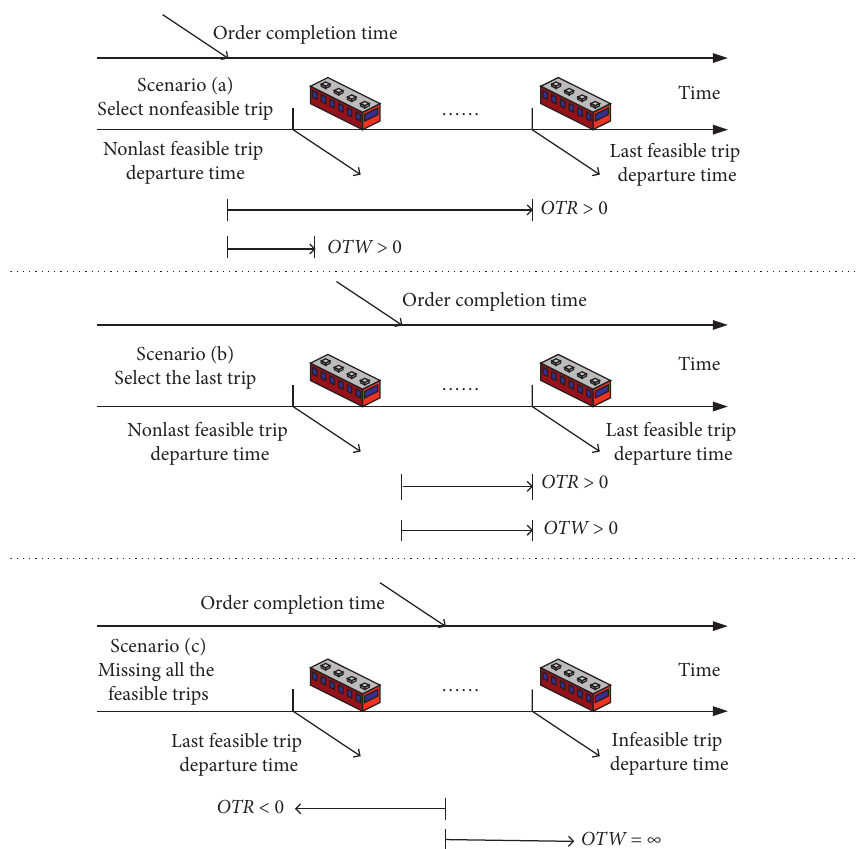
Figure 1: Three different relationships between the order completion time and feasible trip departure time.